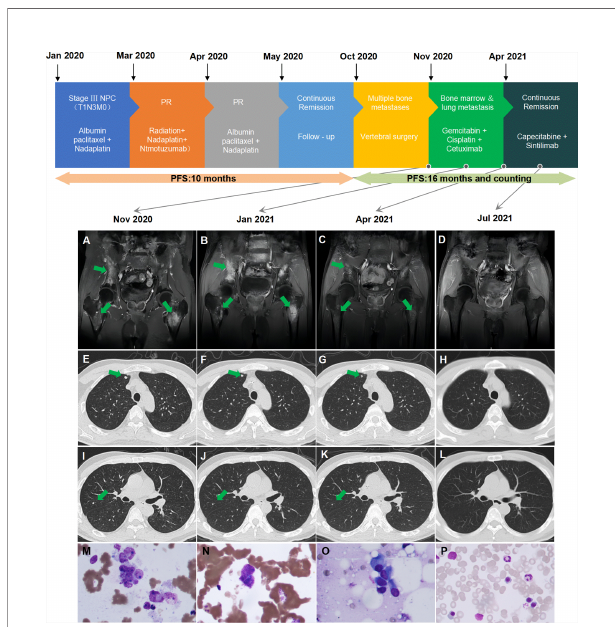
FIGURE 1 | Summary of the patient ’ s treatment history. (A) Multiple bone metastases before second-line treatment. (B) Multiple bone metastases after two cycles of therapy. (C) Reduction of multiple bone metastases after six cycles of therapy. (D) Continued reduction of multiple bone metastases after 3 months of maintenance therapy. (E, I) Multiple lung metastases before second-line treatment. (F, J) Multiple lung metastases after two cycles of therapy. (G, K) PR of multiple lung metastases after six cycles of therapy. (H , L) Disappearance of lung metastases after 3 months of maintenance therapy. (M) Clustered tumor cells con fi rmed bone marrow involvement before second-line treatment. (N) Scattered tumor cells detected after four cycles of therapy. (O) Suspicious tumor cells detected after six cycles of therapy. (P) Bone marrow aspiration negative after 3 months of maintenance therapy. PR, partial response; PFS, progression-free